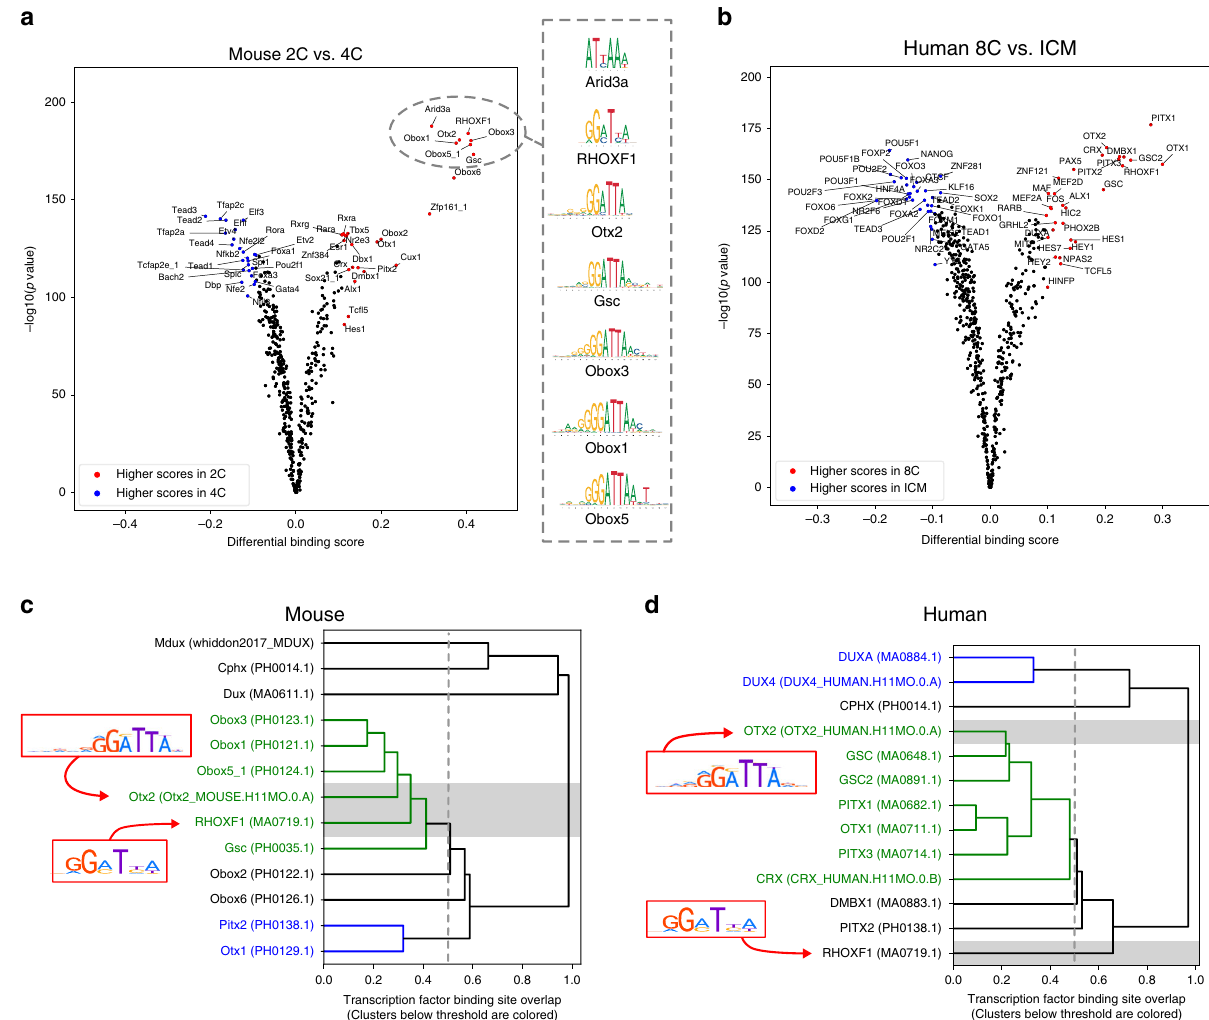
Fig. 3 Speci fi cation of ZGA functions between mouse and human. a , b Pairwise comparison of TF activity between developmental stages. The volcano plots show the differential binding activity against the − log10( p value) (both provided by TOBIAS) of all investigated TF motifs; each dot represents one motif. For a 2C stage speci fi c TFs are labeled in red, 4C speci fi c factors in blue. From the 2C speci fi c TFs, seven prominent examples are chosen and illustrated by their motif. For b 8C stage speci fi c TFs are labeled in red, ICM speci fi c factors in blue. c , d Clustering of TF motifs based on binding-site overlap. Excerpt of the global TF clustering based on TF binding location, illustrating individual TFs as rows. The trees indicate genomic positional overlap of individual TFBS. A tree depth of 0.2 represents an overlap of 80% of the motifs. Each TF is indicated by name and unique ID in brackets. Clusters of TFs with more than 50% overlap (below 0.5 tree distance) are colored in green/blue. The position of TF motifs RHOXF1 and Otx2/OTX2 are highlighted. c shows overlap of motifs included in the mouse analysis. d shows clustering of human motifs. Complete TF trees are provided in Supplementary Notes 1 and